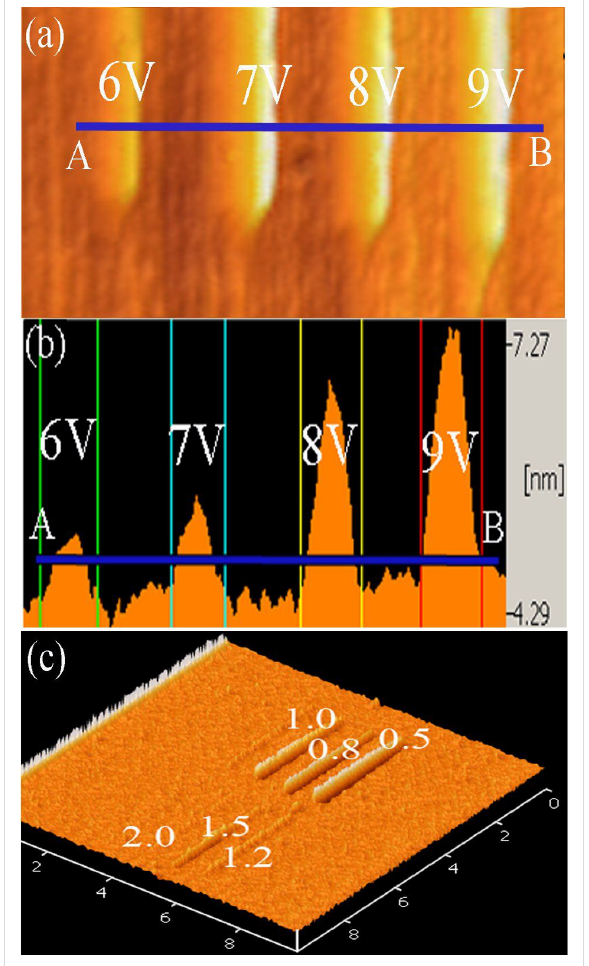
Figure 1: (a) AFM topographic images depicting a series of oxide protrusions produced by applying various voltages in the range 6–9 V. (b) Cross-section profiles along AB lines indicated in (a). (c) Effect of writing speed at a constant voltage of 9